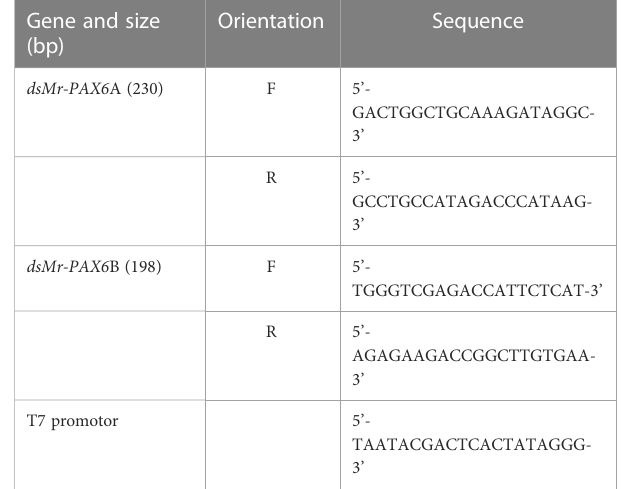
TABLE 2 Primers for dsRNA